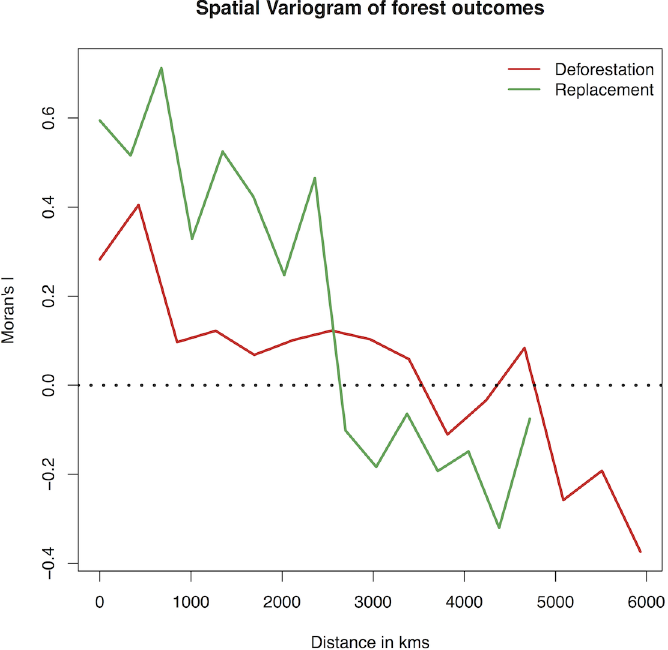
Fig 2. Spatial autocorrelation in Pre-European Pacific forest outcomes. Spatial variogram showing degree of spatial auto-correlation in deforestation (green) and replacement (red) as a function of geographic proximity (distance between islands).